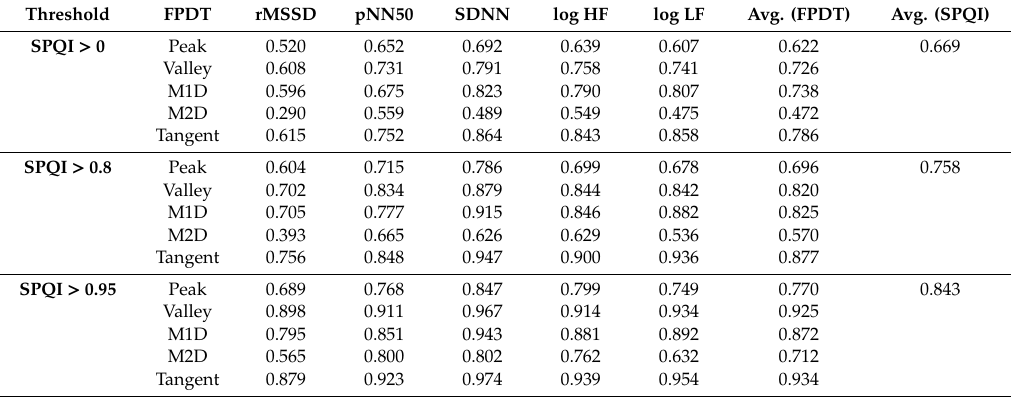
Table 3. Correlation coe ffi cients between the results generated by smartphone PPG and ECG.